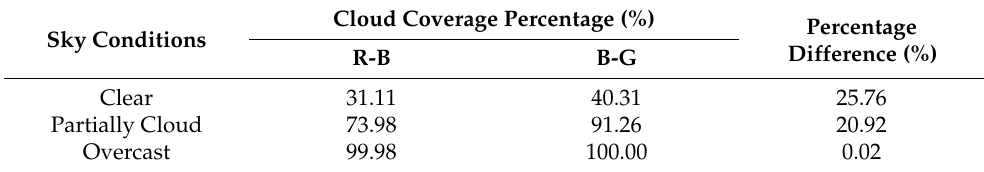
Table 2. Cloud Coverage Percentage for both Color Difference in three different sky conditions .